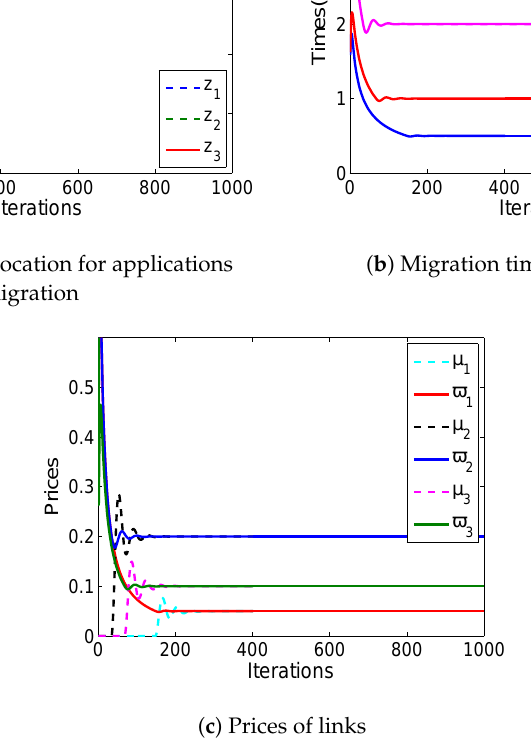
Figure 6. Performance of the bandwidth allocation algorithm for application migration with ϑ = 0.4 and ς =